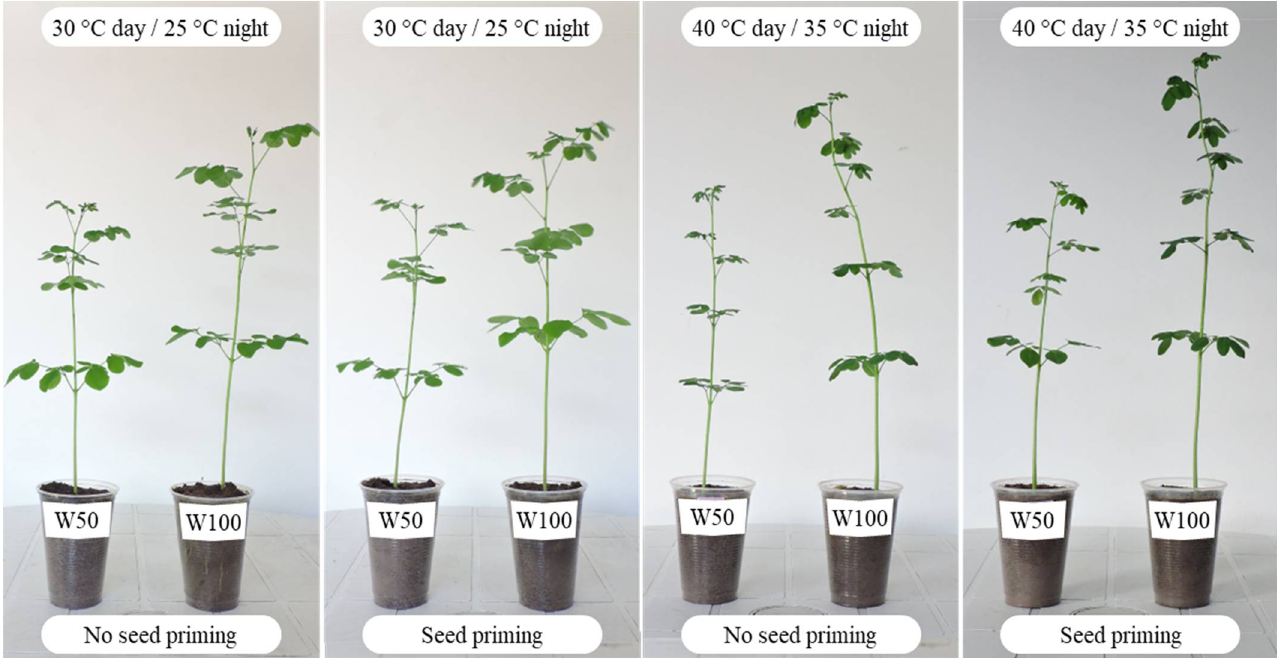
Figure 3. Seedlings of Moringa oleifera subjected to seed priming, soil water replenishment, and temperature change. W50, water stress; W100, no water stress.